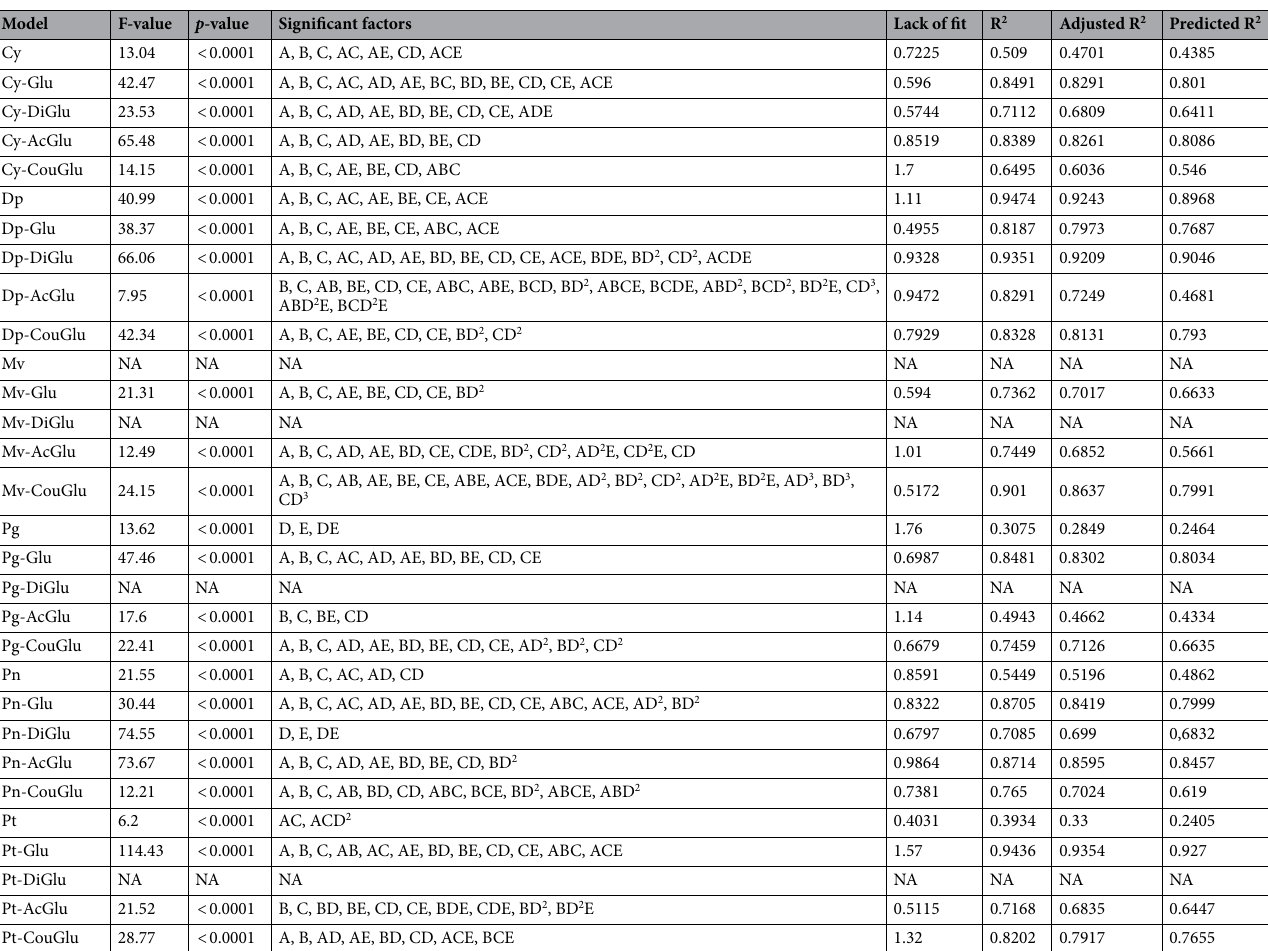
Table 3. Factors and factor interactions used to predict anthocyanin concentrations and model characteristics to ensure significance. We preselected factors showing a significant influence on the biomass yield by automated backward selection with a p-value threshold of 0.100. Factors with a p-value > 0.1 were removed, except those needed to maintain the model hierarchy. A p-value of 0.1 indicates a significance (α) level of 10%. Cy = Cyanidin, Dp = Delphinidin, Mv = Malvidin, Pg = Pelargonidin, Pn = Peonidin, Pt = Petunidin, Glu = Glucoside, DiGlu = Diglucoside, AcGlu = Acetylglucoside, CouGlu = Coumaroylglucoside. Factors: A = Red, B = Green, C = Blue, D = Week, E =